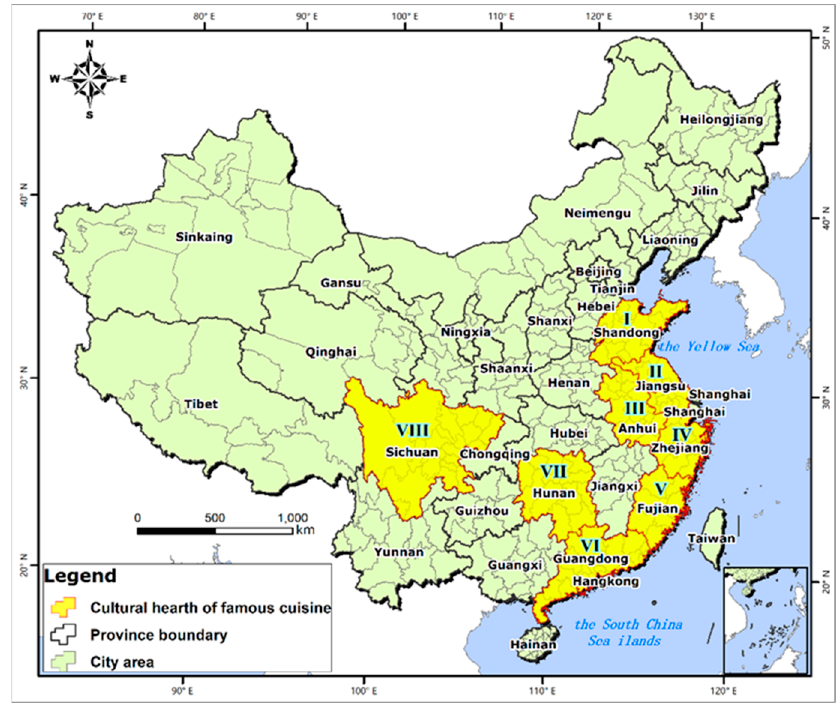
Figure 1. Study area and cultural hearth of eight famous Chinese cuisines.